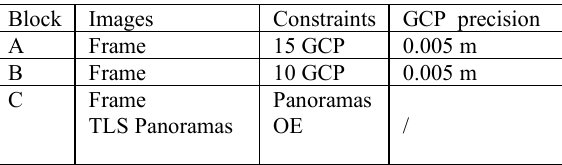
Table 1. Parameters used for orientation process . Block A and Block B differ in the strength of the control